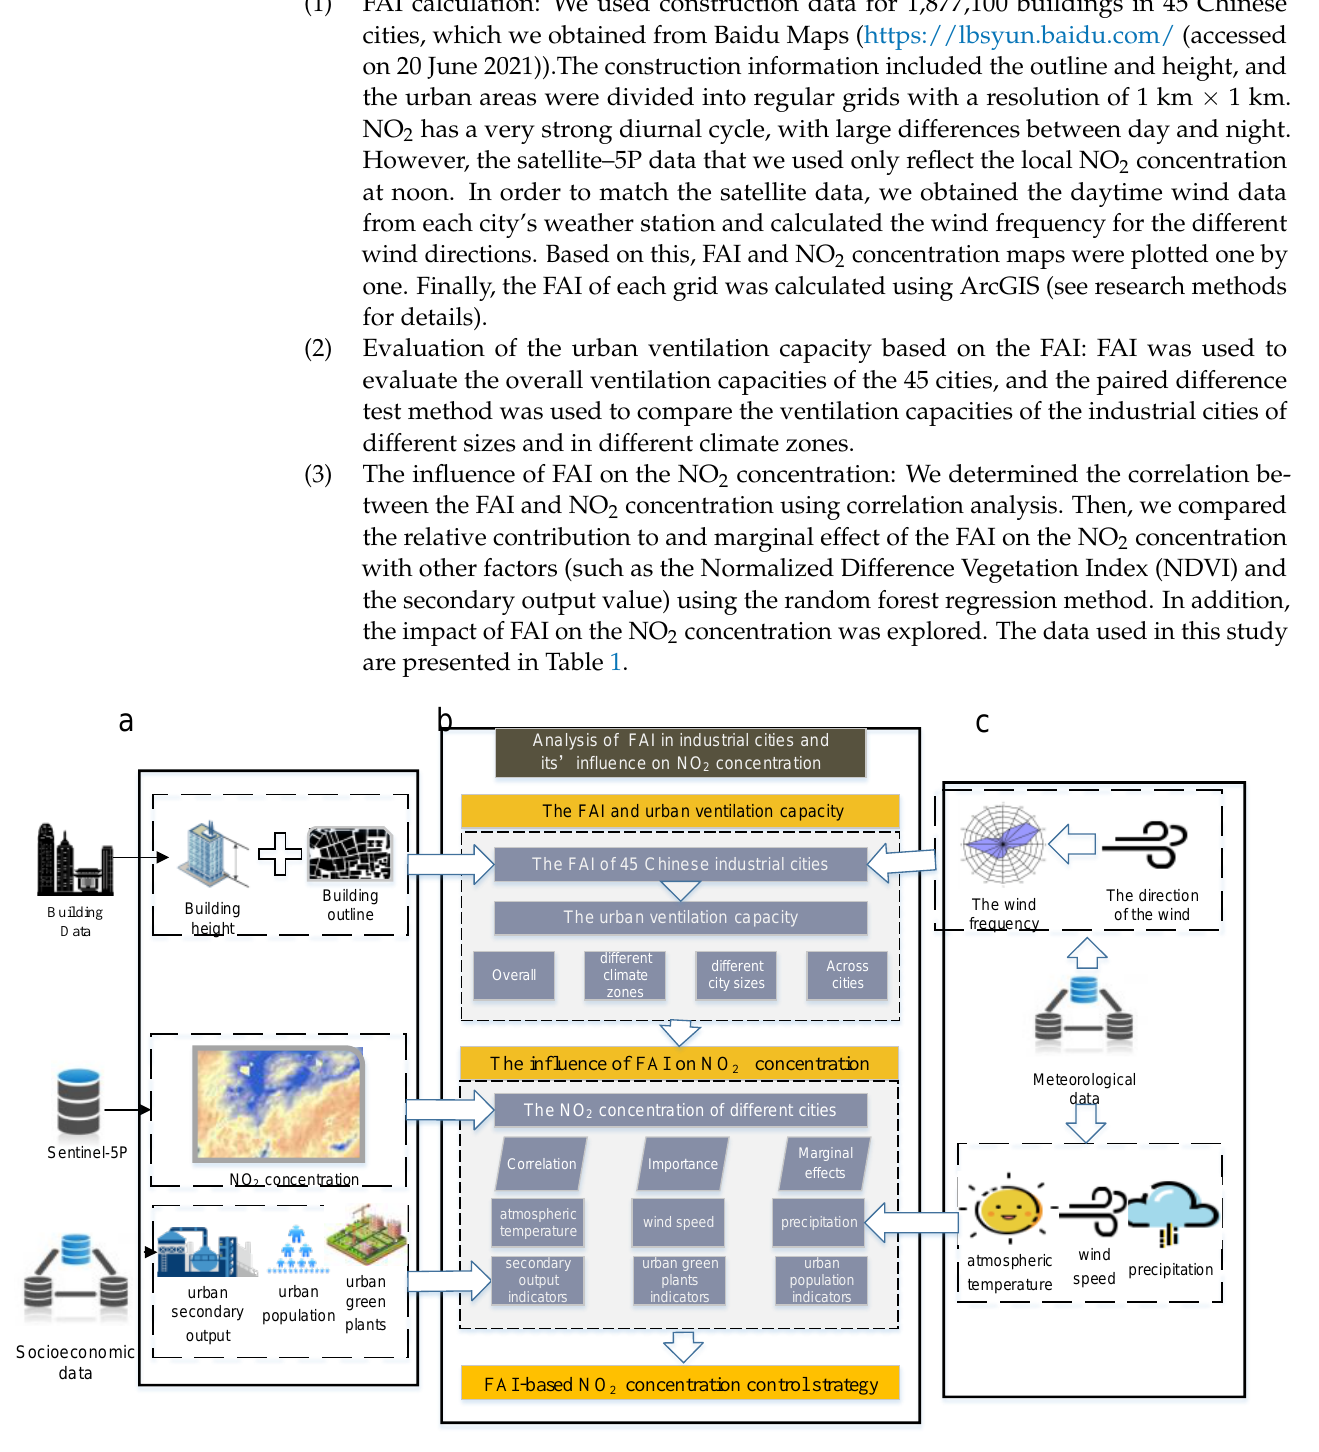
Figure 2. Research framework: ( a ) data sources are presented, including construction data, NO 2 concentration data, and some socio–economic data; ( b ) the specific process of the research is shown, in which the yellow part represents the research content, and the gray part represents the research data and research methods; ( c ) data sources are presented, including wind speed, wind direction, and other natural data. Table 1. Data sources.